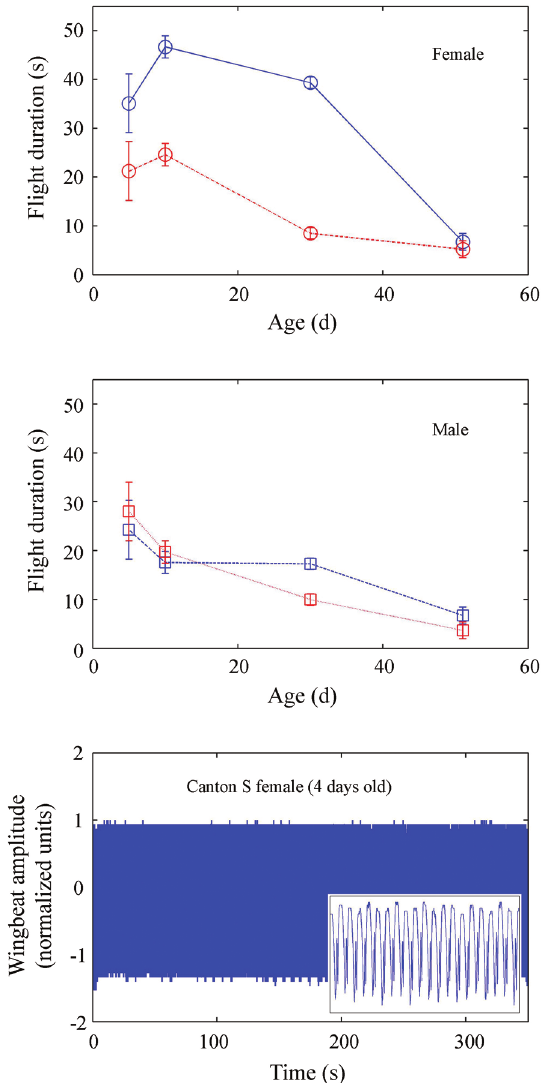
Figure3 -Durationofthelongestsegmentofsustainedflightasafunction of age and genotype. Top panel shows data for females and middle panel for males. Error bars represent one standard error. Bottom panel shows an extended uninterrupted flight of 5 min (approximately 50,000 wingbeats) bya4-dayoldfemaleCanton-Swild-typeflymeasuredusingthesameap- paratus and procedures employed in the current study. hSOD1 and their parental controls maintain flight at considerably shorter durations than wild types. Inset shows a 120 millisecond segment (20 wingbeats) of the waveform in the bottom